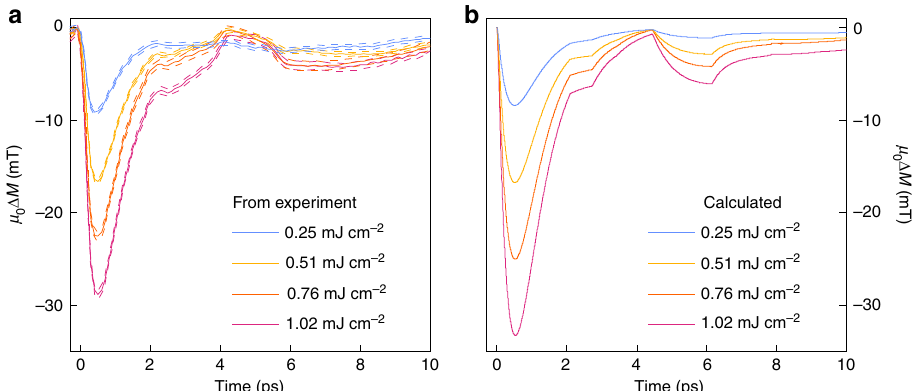
Fig. 3 Comparison of measured and simulated magnetization dynamics M ( t ) in laser-excited MgO/Fe/MgO sample in this work. a Ultrafast magnetization dynamics in the Fe fi lm at various laser pump fl uences in the range 0.25 – 1.02 mJ cm − 2 with errors shown by dashed lines, and b results of simulation corresponding to the experimental scenario in ( a ). The error bars in ( a ) were determined from the standard errors in the measured electro-optic signals (from 200 individual measurements). The experimental error was then propagated in the reconstruction protocol, leading to the intervals as